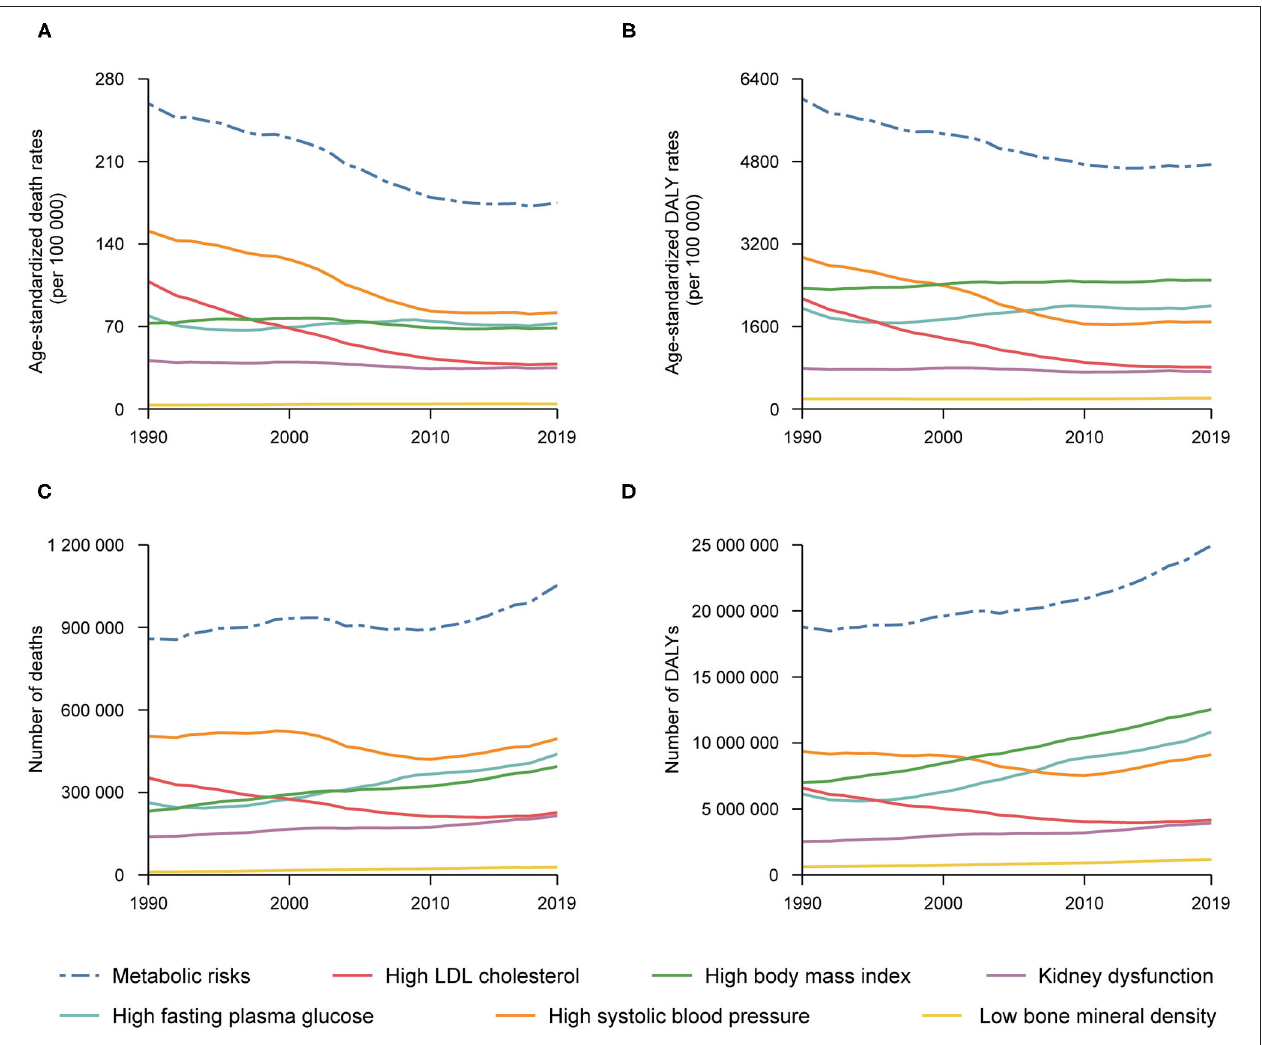
FIGURE 1 | Numbers and age-standardized rates of deaths and DALYs attributable to individual and combined effects of metabolic risks in the United States, 1990–2019: Age-standardized rates of deaths (A) and number of deaths (C) attributable to individual and combined effects of metabolic risks, and age-standardized DALYs rates (B) and number of DALYs (D) attributable to individual and combined effects of metabolic risks.